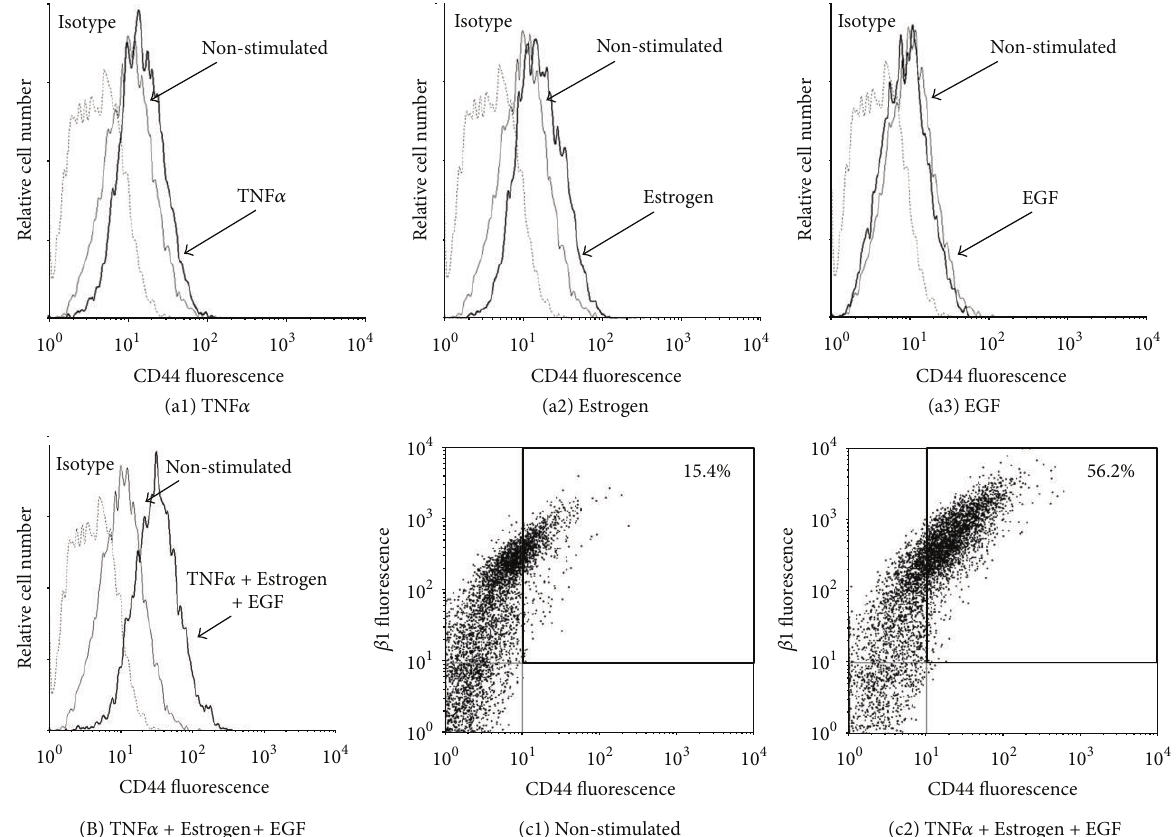
Figure 5: Combined stimulation of breast tumor cells by TNF 𝛼 + Estrogen + EGF leads to potent induction in expression of CD44 and to emergence of a CD44 high / 𝛽 1 high cell population. ((a), (B)) Determination of CD44 expression. Breast tumor cells were stimulated by (a1) TNF 𝛼 , (a2) estrogen, (a3) EGF, or (B) TNF 𝛼 + Estrogen + EGF (concentrations as in Figure 1) for three days. Non-stimulated: cells grown with the diluents of the above factors. The expression of CD44 on the surface of the cells was determined by FACS analyses, using specific Abs to CD44. Isotype: isotype matched Abs used as control in the FACS analyses. In all panels, the results are from a representative experiment of 𝑛 ≥ 3 . (c) Coexpression of CD44 and 𝛽 1. (c1) Non-stimulated: cells grown with the diluents of the above factors. (c2) Cells stimulated by TNF 𝛼 + Estrogen + EGF (concentrations as in Figure 1). The expression of CD44 and 𝛽 1 on the surface of the cells was determined by FACS analyses using specific Abs, with axes set based on staining with isotype matched control Abs. In all panels, the results are from a representative experiment of 𝑛 ≥ 3